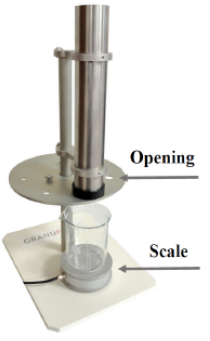
Figure 1. Diagram of GranuFlow (cid:114) equipment. It is equipped to with cylindrical stainless steel tube and a disk with 7 di ff erent diameter size openings through which the powder pass from each opening one by one and it fall into a container. A scale placed under container measures continuously the powder mass.